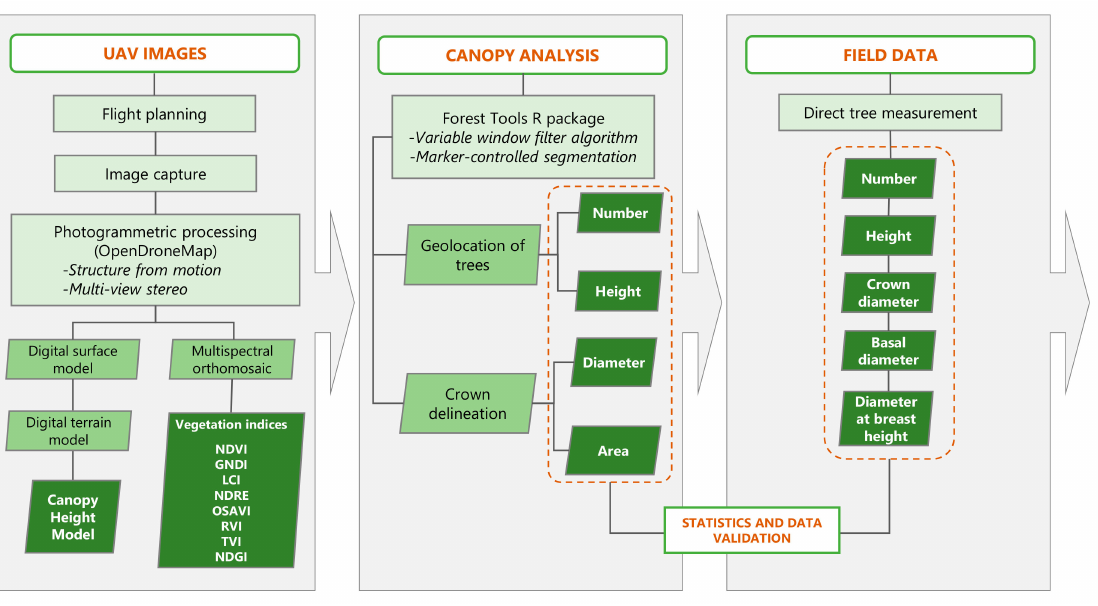
Figure 2. Workflow of stages of unmanned aerial vehicle (UAV) image preprocessing, canopy analysis, and validation with field